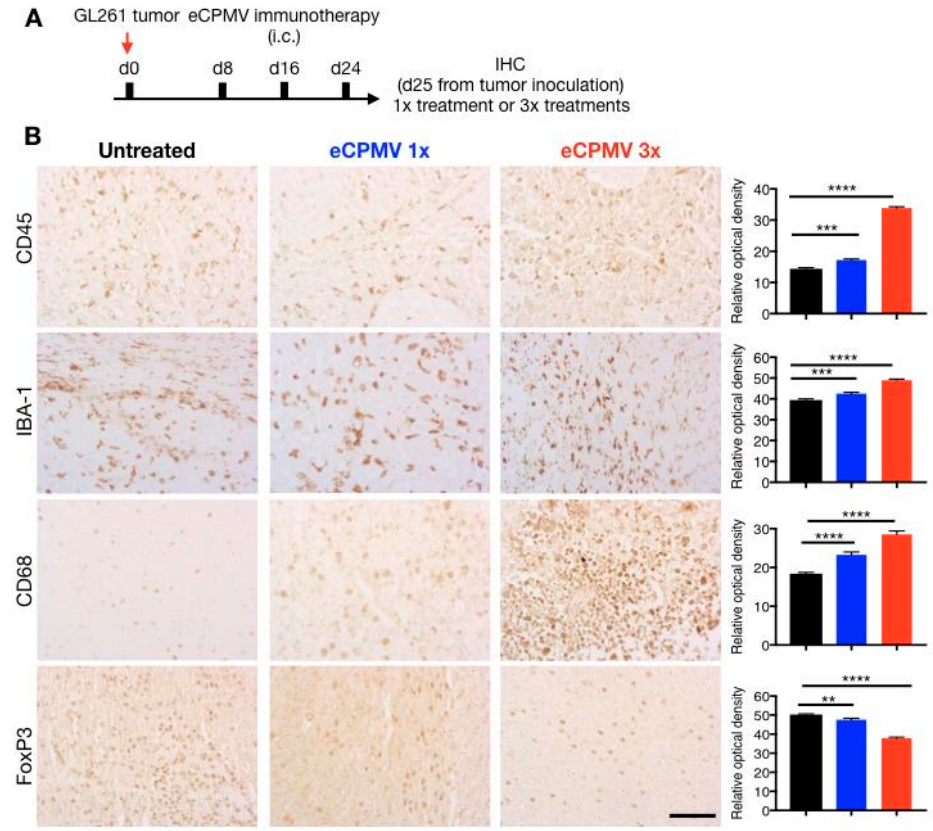
Figure 4. Immunohistochemical analysis. ( A ) Brain tissues from GL261 glioma bearing mice ( n = 3) were harvested on day 25 from tumor inoculation after 24 h of receiving 1 × eCPMV treatment or the last dose of 3× eCPMV treatment. ( B ) Tumor sections (6 μ m thick) were stained with α -CD45 antibody, α -IBA-1 antibody, α -CD68 antibody and α -FoxP3 antibody. The scale bar is 50 μ m in all images. Quantitative analysis was performed using Zeiss software to determine relative optical densities of the stained sections. Error bars represent SEM. Statistical analysis was performed using ordinary one-way ANOVA (Tukey’s multiple comparison test (**** p < 0.0001, *** p < 0.001, ** p <